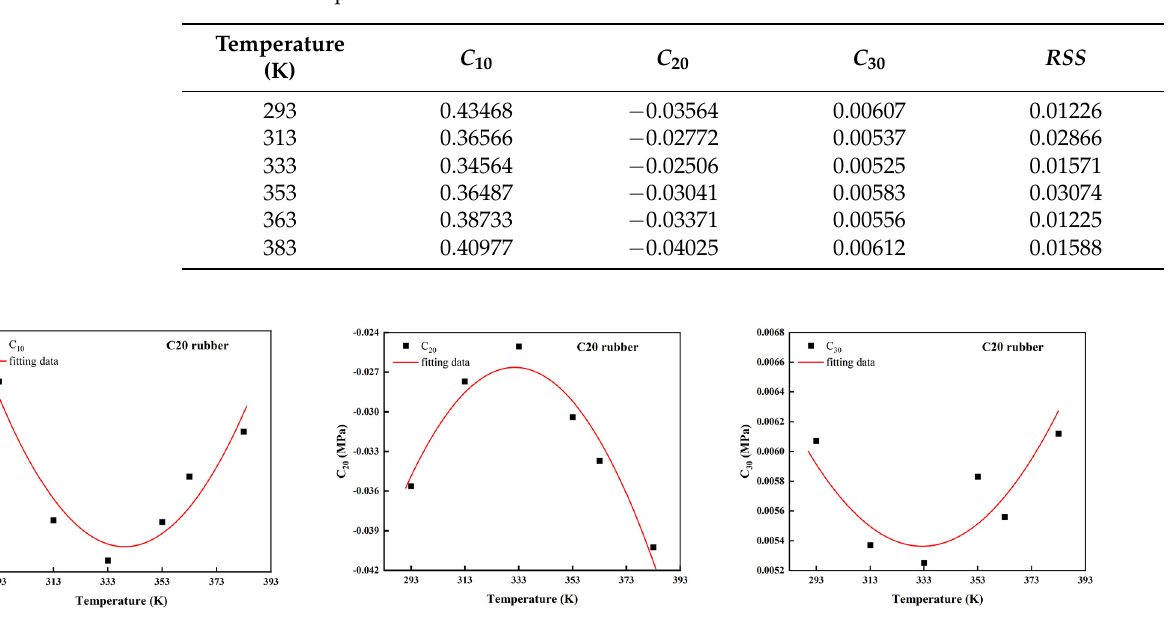
Table 3. Parameters fitting of the Yeoh model with the experimental data of the C20 rubber specimen at different temperatures.